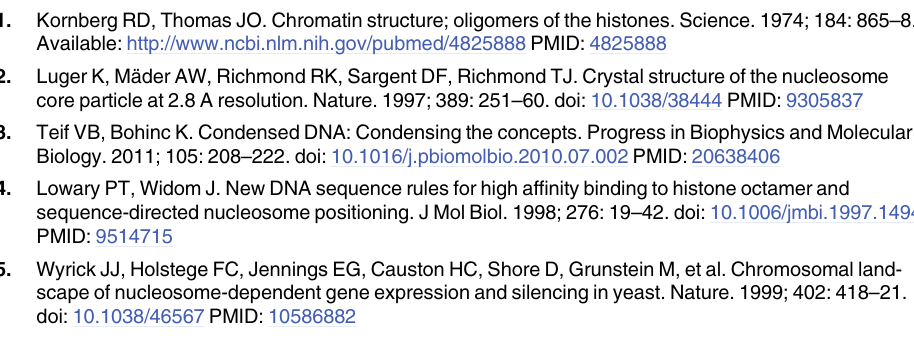
S3 Fig. Transcription factor binding sites used in this study. Position weight matrices obtained from the TRANSFAC or JASPAR public databases are shown as sequence logos. Logos were generated using the seqLogo R package from Bioconductor. (TIF) S4 Fig. Nucleosome proximity and nucleosome-bound periodicity of rare transcription fac- tor binding sites. Of the 17 transcription factors studied in this report, 8 were excluded due to insufficient binding sites ( < 300) in the Ly49 gene family. The (A) nucleosome proximity and (B) nucleosome-bound periodicity for these excluded factors are indicated here. (TIF) S5 Fig. Nucleosome proximity of all factors across mouse chromosome 6. Factor-nucleo- some distances were calculated and presented as in Fig 2. As the whole chromosome was used, all factors gave sufficient signal to generate histograms. (TIF) S6 Fig. Transcription factor periodicity for all predicted nucleosome-bound regions in chromosome 6. Factor periodicities were calculated and presented as in Fig 3. Graphs show the periodgram of the entire amalgam (black) and the effect of removing the indicated factor from the amalgam (red). The histogram highlights the effect of removing each factor individual on the 10 bp